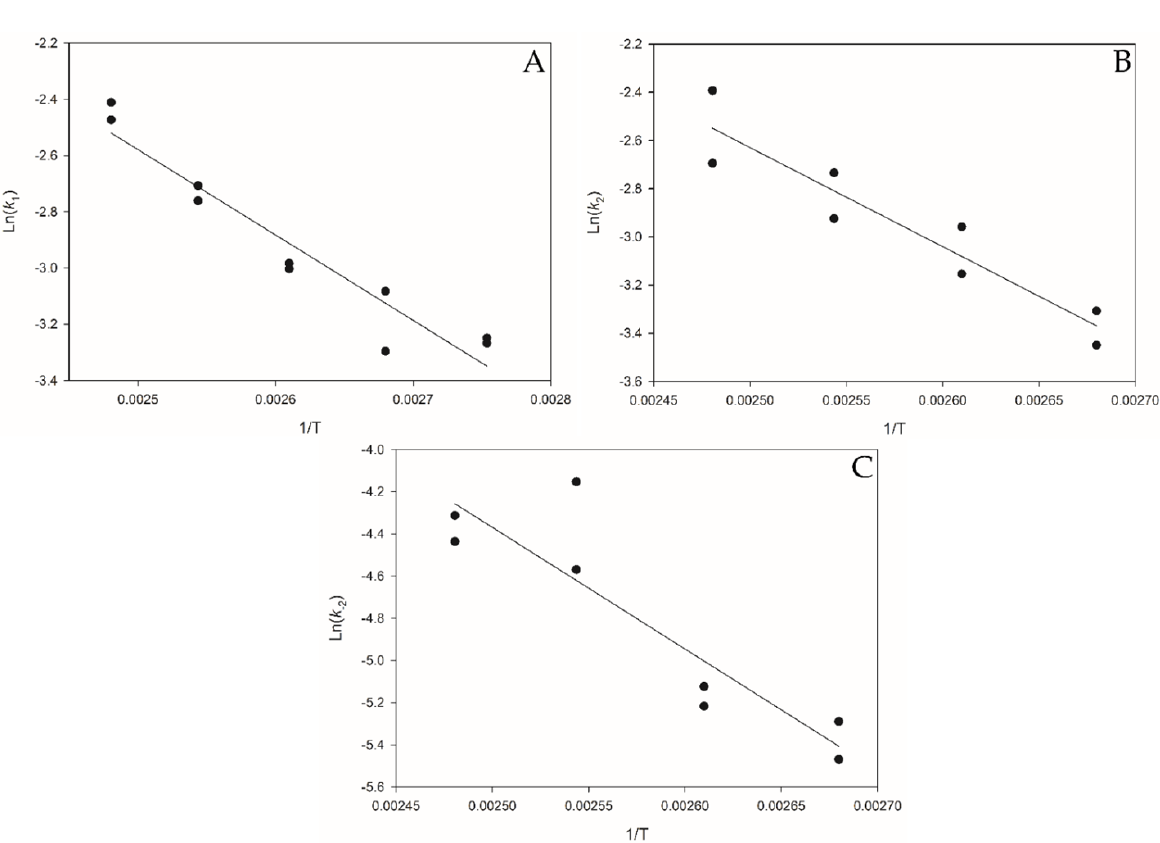
Figure 5. Arrhenius plots for Methanolysis of 2 g PLA, at 600 rpm, 17 equivalents MeOH and 2 mol% Zn(OAc) 2 . ( A ) = k 1 y = − 3035.9x + 5.01 R 2 = 0.9176. ( B ) = k 2 y = − 4111.2x + 7.6487 R 2 = 0.8867. ( C ) = k − 2 y = − 5767.6x + 10.05 R 2 =